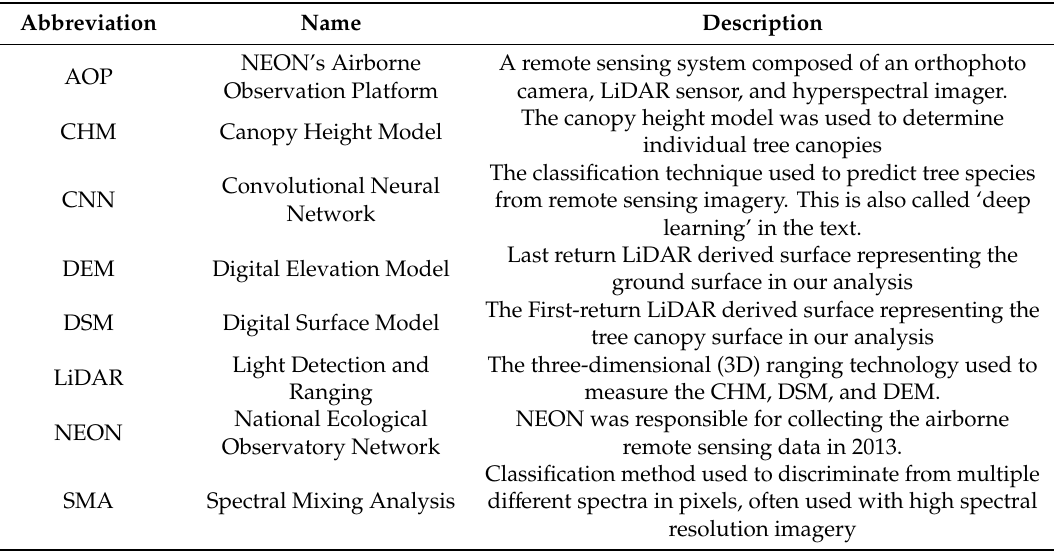
Table A1. List of Abbreviations used in this